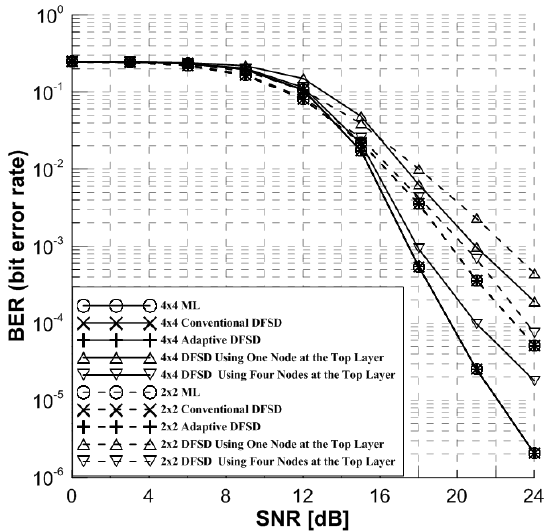
Figure 6. The error performance of the detection schemes with 16-quadrature amplitude modulation (QAM).